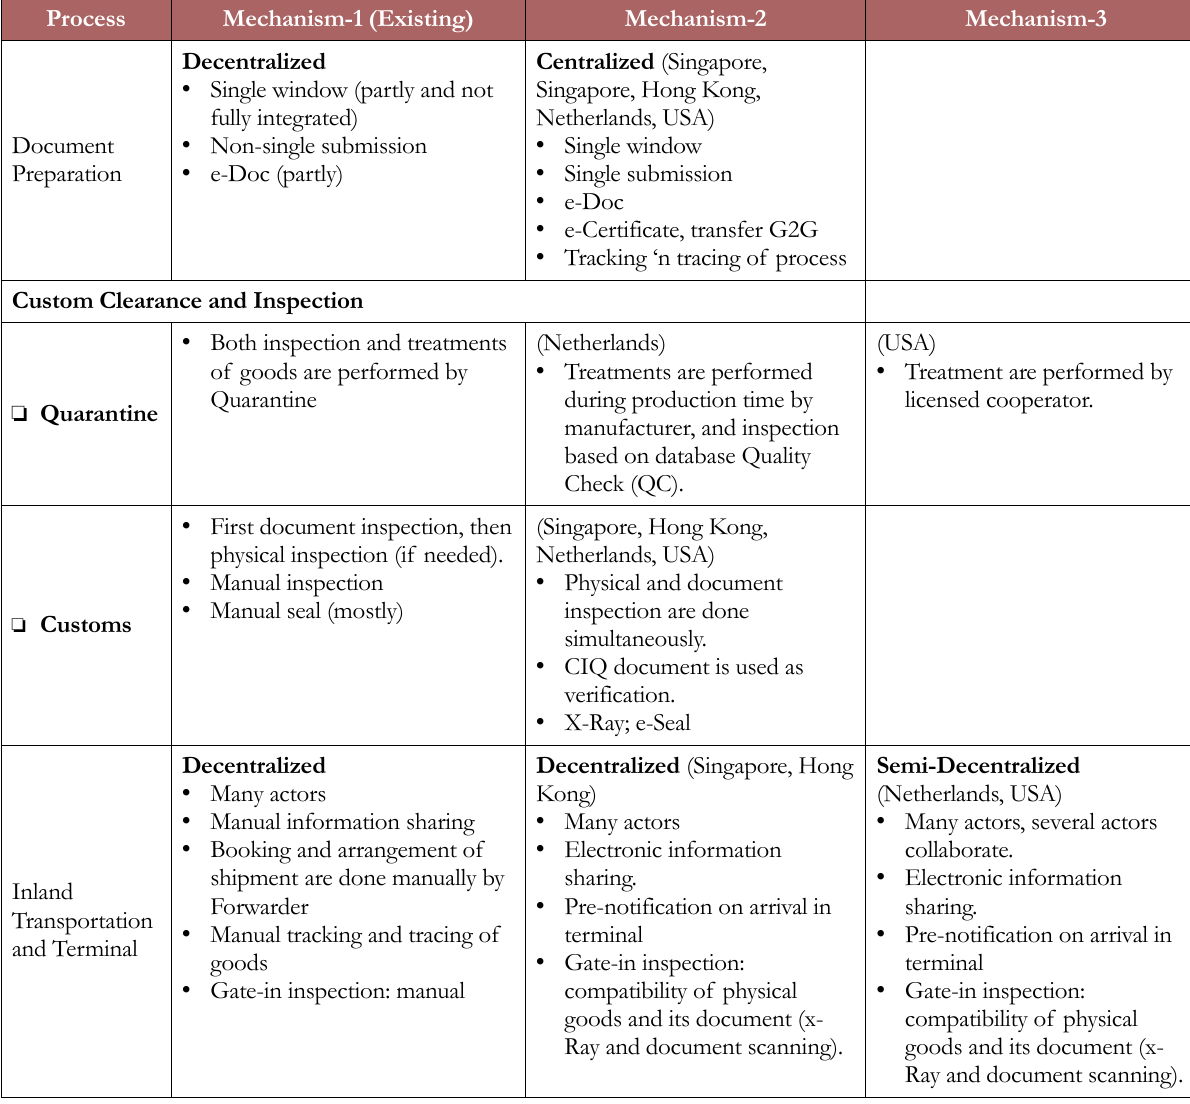
Table 3. Existing and Benchmark of Inter-Organizational